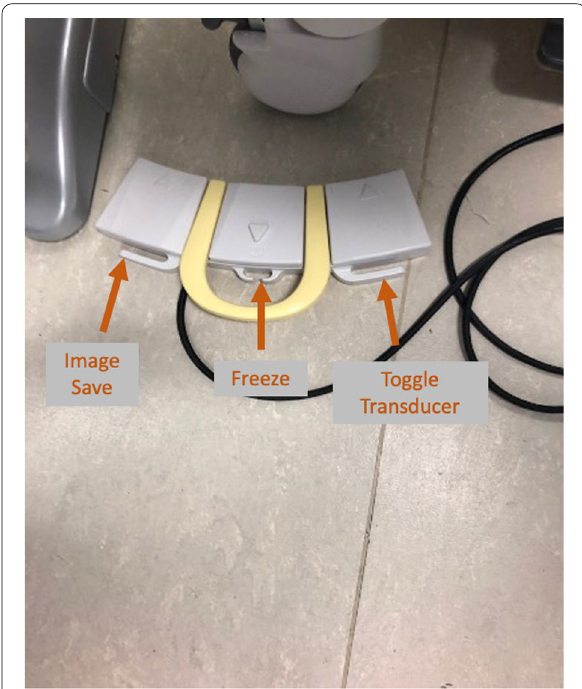
Fig. 3 Three gang footswitch (Hitachi Medical Systems, Germany)